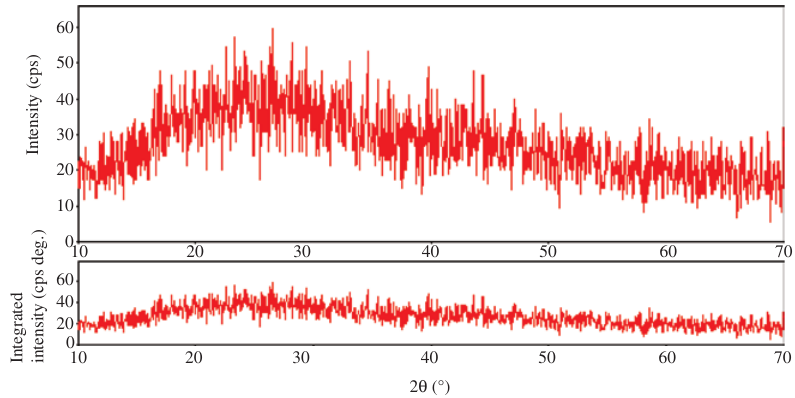
Figure 20: XRD analysis of GFRP composites with 3%